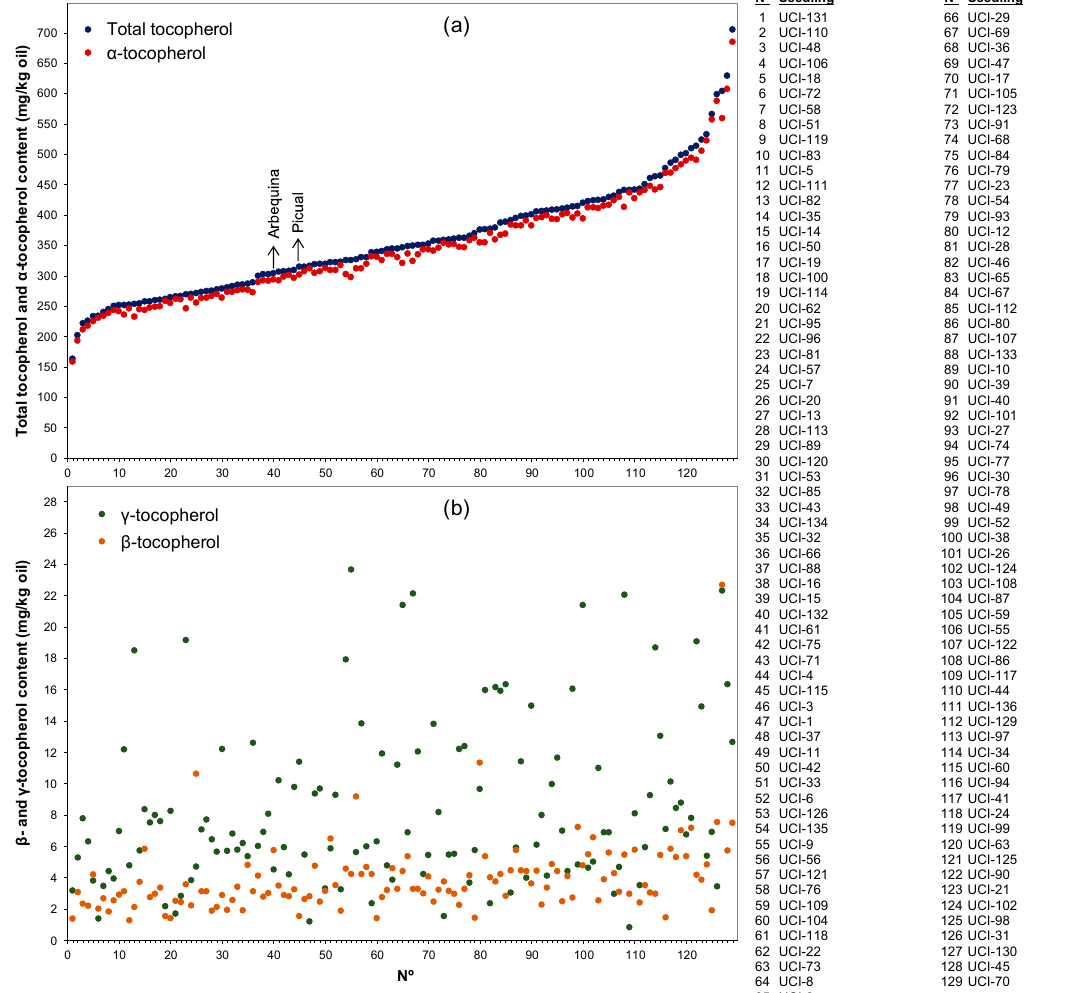
Figure 3. Content of tocopherols in the oils produced by one hundred twenty-nine seedlings from the segregating population of the cross of the cultivars ‘Picual’ and ‘Arbequina’: ( a ) total tocopherol and α -tocopherol; ( b ) β - and γ –tocopherol. The level of tocopherols of the genitors are marked in the ( a ) plot for comparison. Olive fruits at turning stage were hand-picked over the crop years 2008–2017, processed for oil extraction in the same conditions and each sample analyzed twice for tocopherol content.